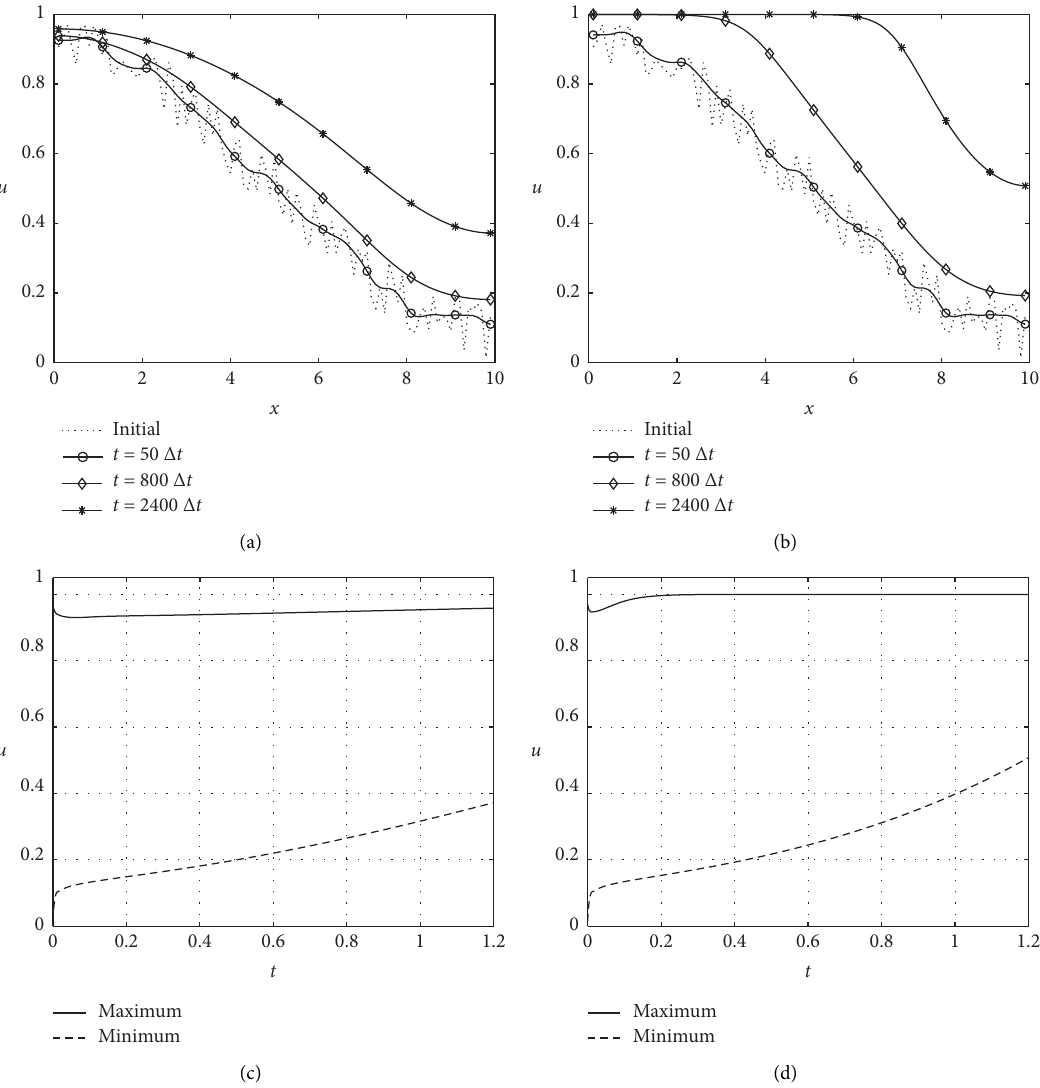
Figure 13: (a, b) Numerical solution of u with (a) p � 1 and (b) p � 20. (c, d) Temporal evolution of the minimum and maximum of u when (c) p � 1 and (d) p �